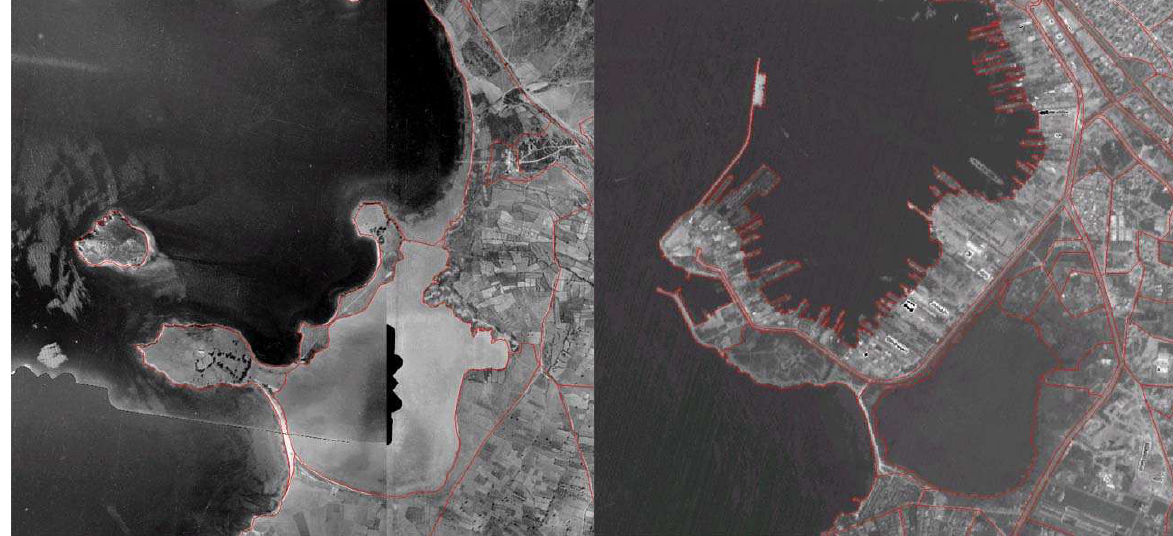
Figure 6: Example of a costal area at the Marmara Seaside SE of Istanbul in the year 1945 (left) and in the Year 2000 (right)